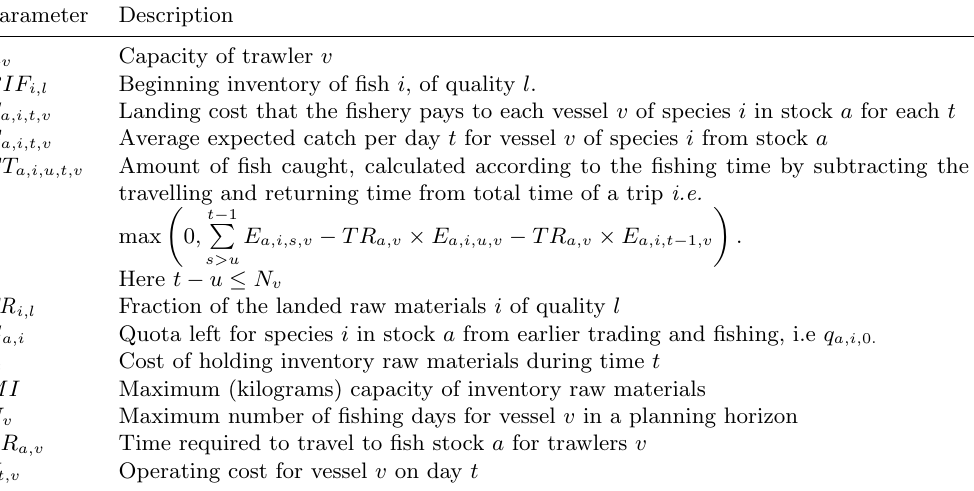
Table 2: Fishing parameters.